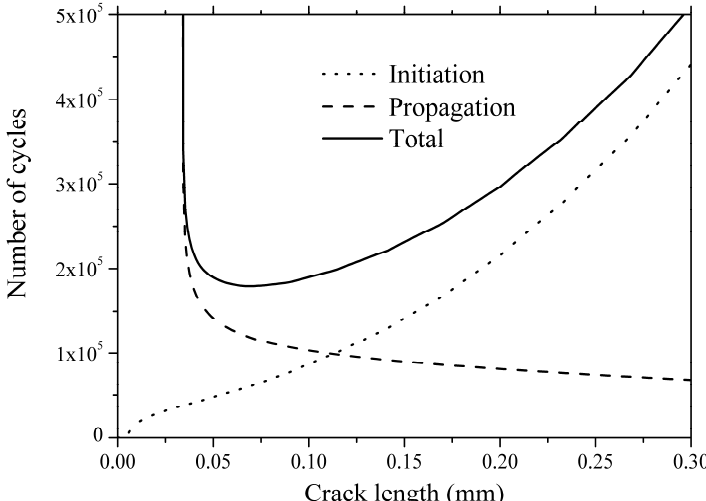
Figure 7: Curves N i ( a ), N p ( a ) and N t ( a ) obtained in a 3D